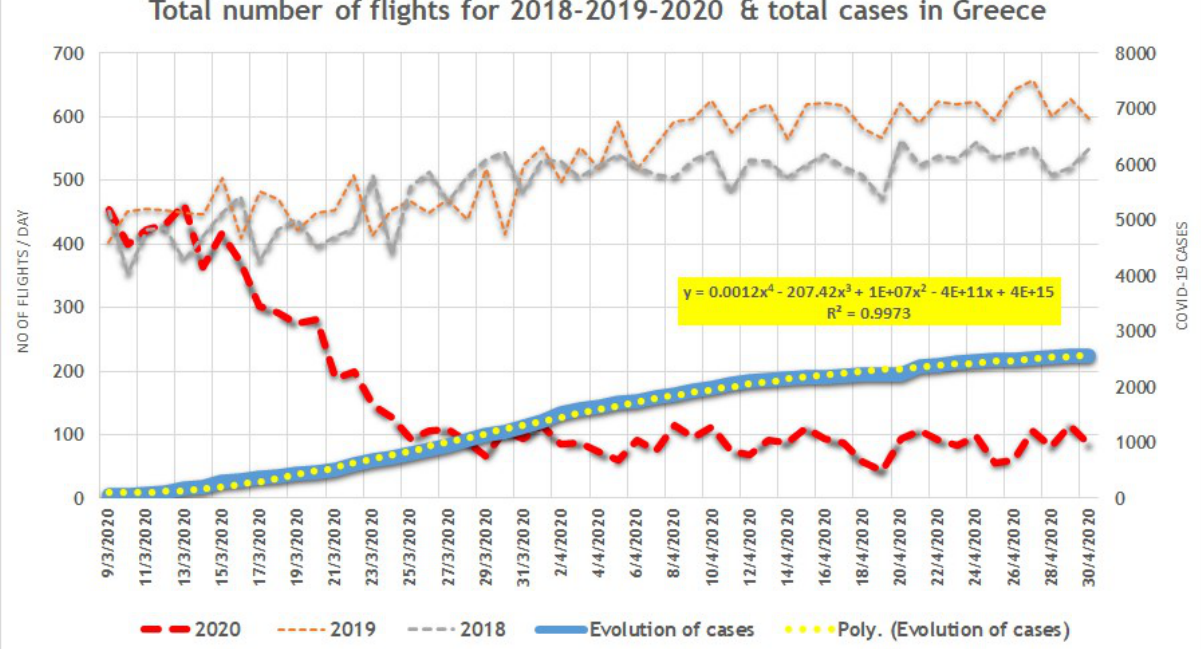
Figure 10: Total number of flights and total coronavirus